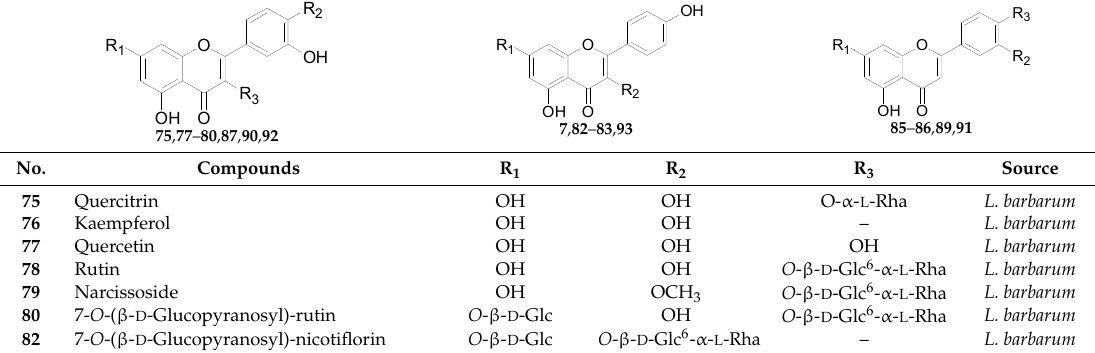
Figure 5. Chemical structures of compounds 63 – 64 and 68 – 74 .